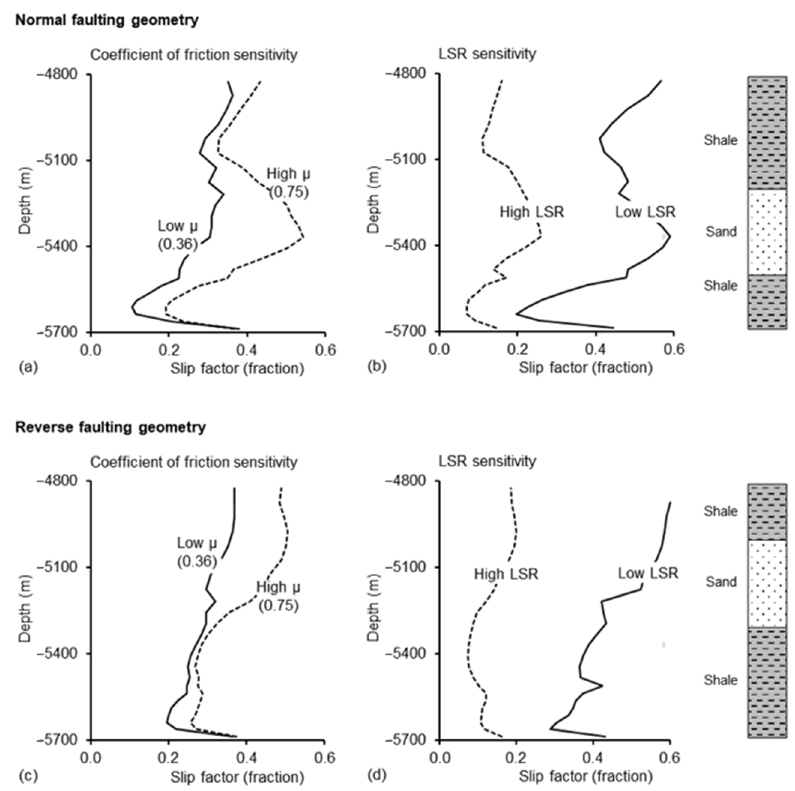
Figure 16. Fracture slip factor ( FSF ) along the fault surface for different surface friction conditions ( a , c ) and different LSR ratios ( b , d ) for normal fault ( a , b ) and reverse fault ( c , d ) geometries. The plots are based on the FE analysis stress output on the fault surface of the HW block.